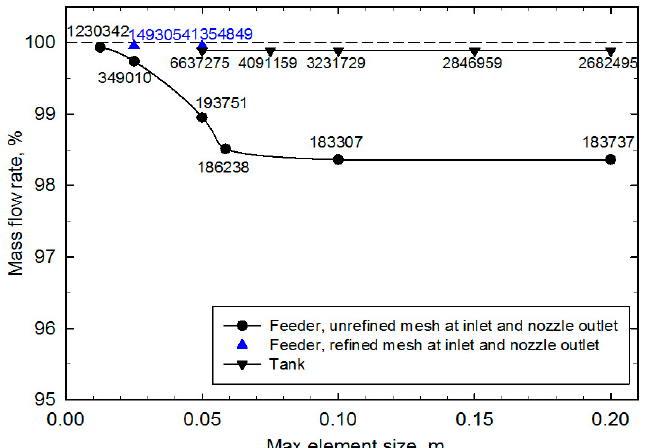
Figure 10. Sensitivity analysis in terms of computed percent of total oil flowrate through feeder and tank. The number of used elements is indicated in every point. Refined mesh at feeder inlet and nozzle outlets improved calculations accuracy.